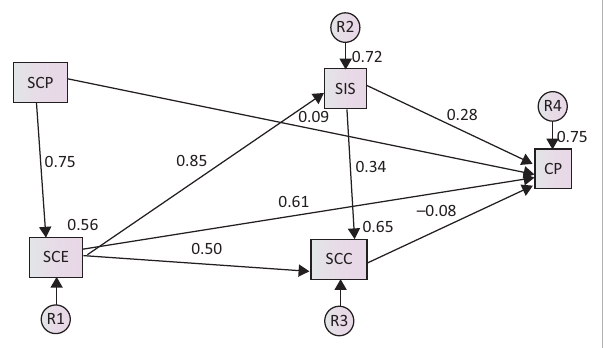
FIGURE 2: Structural equation modelling hypotheses testing results. SCP, supply chain practice; SCE, supply chain e-collaboration; SIS, strategic